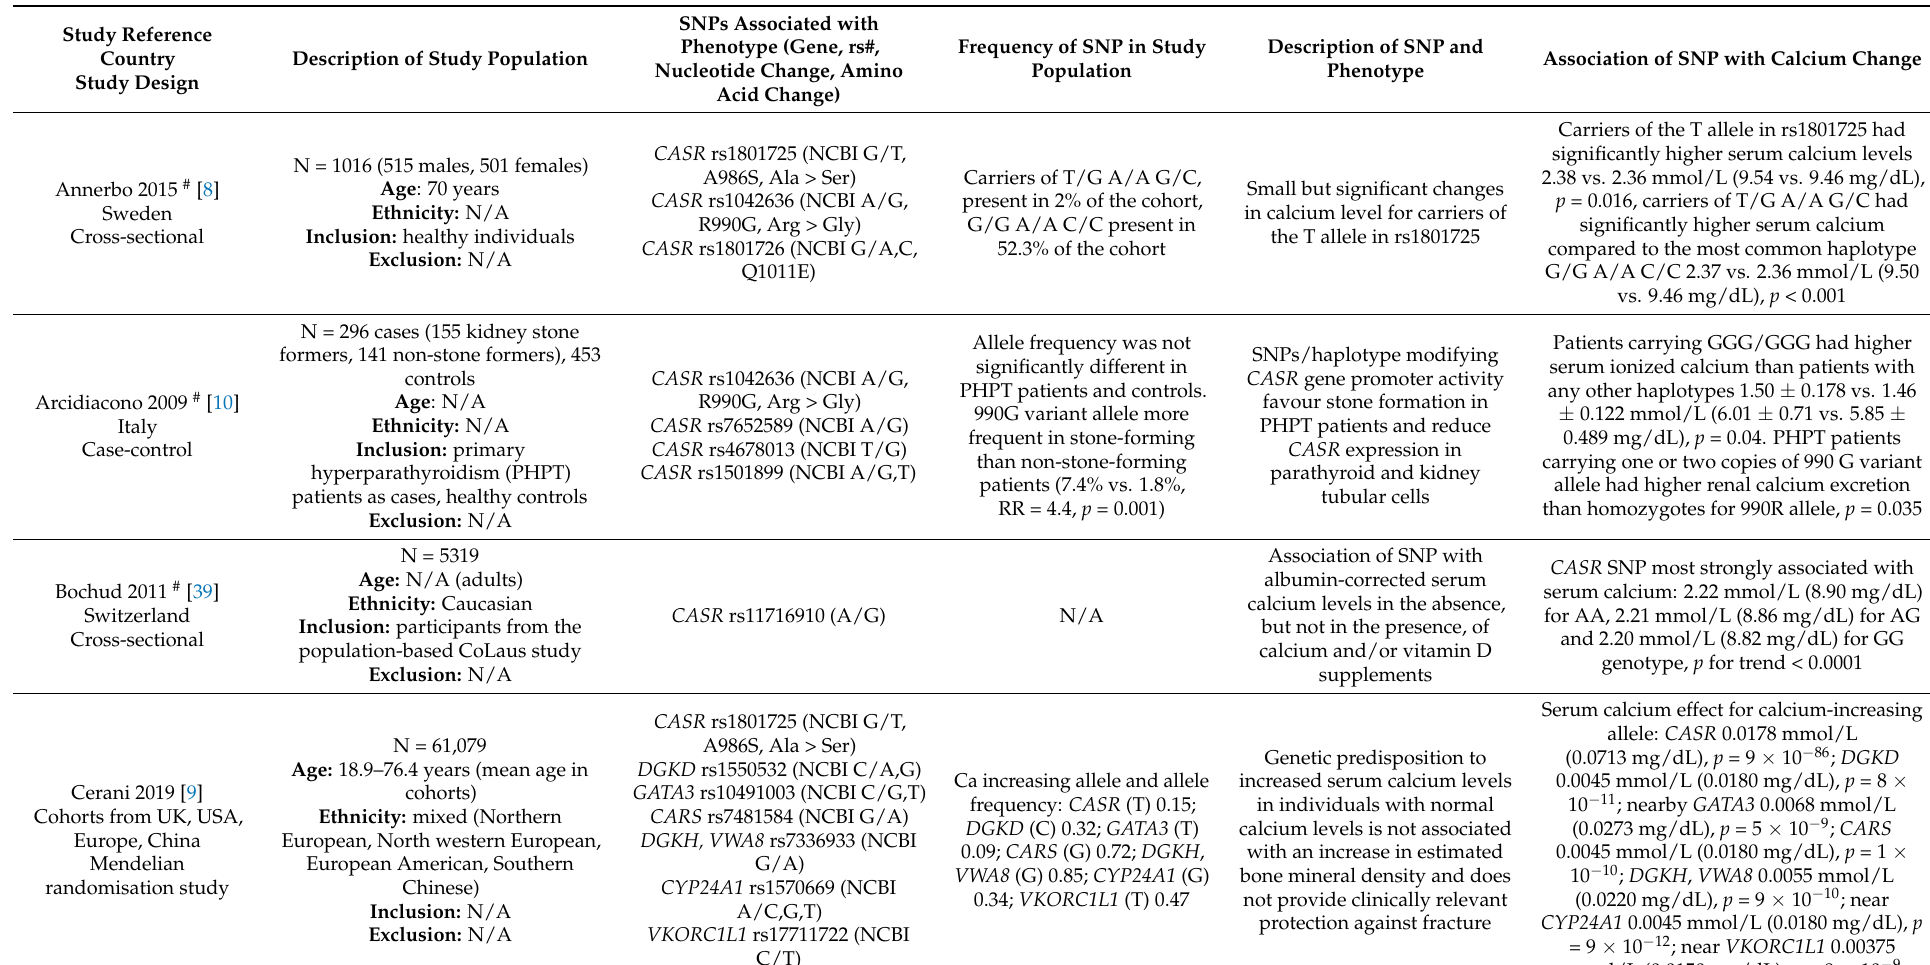
Table 2. Characteristics of studies assessing polymorphisms of the calcium sensing receptor